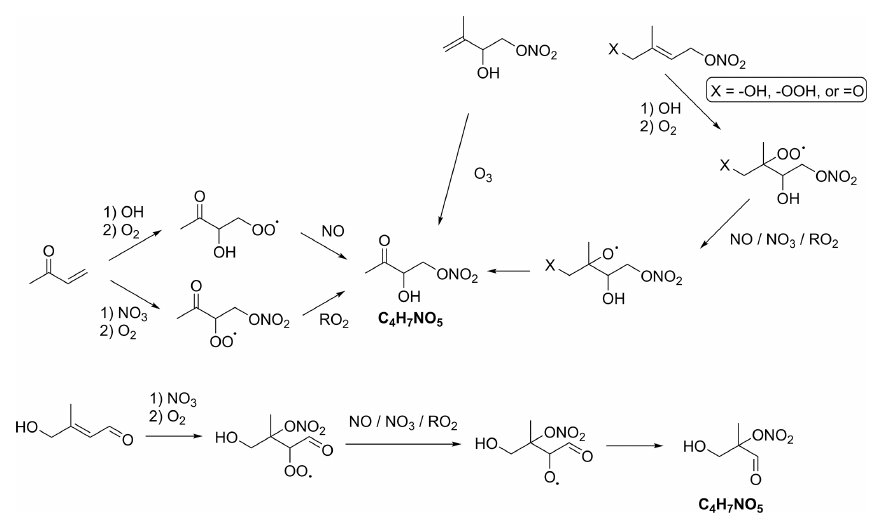
Figure 5. Formation of C 4 H 7 NO 5 compounds. Only two isomers are shown here; other formation routes for these and other isomers are also present. Additional reaction products will also be